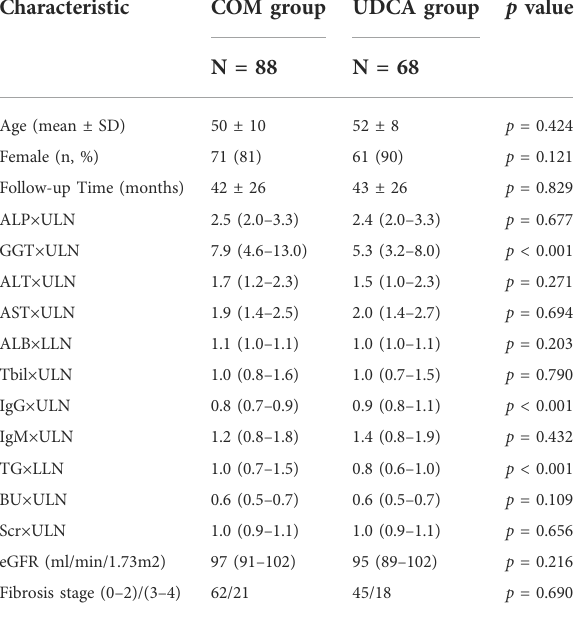
TABLE 3 Baseline characteristics of patients with UDCA-refractory primary biliary cholangitis treated with “ UDCA + FF ” or “ UDCA monotherapy ”